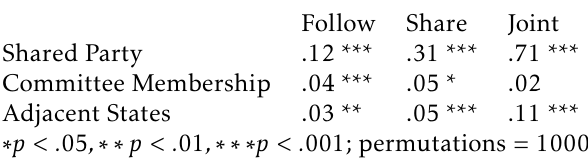
Table 2. QAP Correlations with Covariate Networks